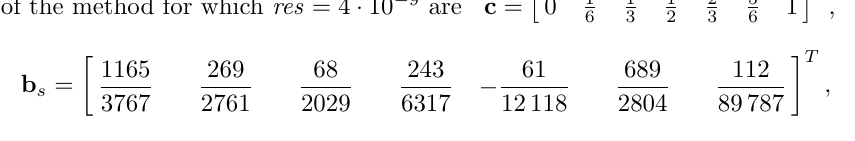
Figure 3. Stability regions of approximation of order p = 6 to exp( z ), of GLM with IRKS corresponding to η = 0 . 59, and of GLM with s = 7 and p = 6 with QS with residual = 4 · 10 − 9 . Stability region of optimal quadratic polynomial q opt cannot be distinguished from stability region of GLM with QS. We have plotted in Fig. 3 the stability region of the method corresponding to f ( A , V , b s ) equal to 4 · 10 − 9 and stability region of q opt ( w, z ) corresponding to p = s − 1 = 6, given in Section 3. For comparison, we have also plotted the sta- bility region of the approximation of the same order to exp( z ). The coefficients (cid:10) of the method for which res = 4 · 10 − 9 are c =